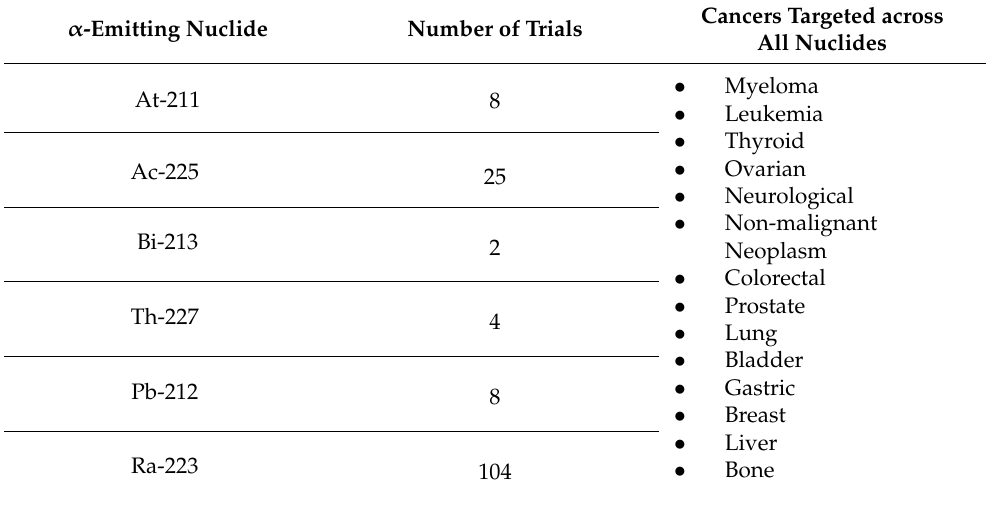
Table 4. All Active Trials Utilizing Available α -Particle Radionuclides for Cancer Therapy. Studies can be found by using the clinicaltrials.gov search tool with radionuclide terms formatted as in the following example: At-211 OR 211At OR Astatine-211. α -Emitting